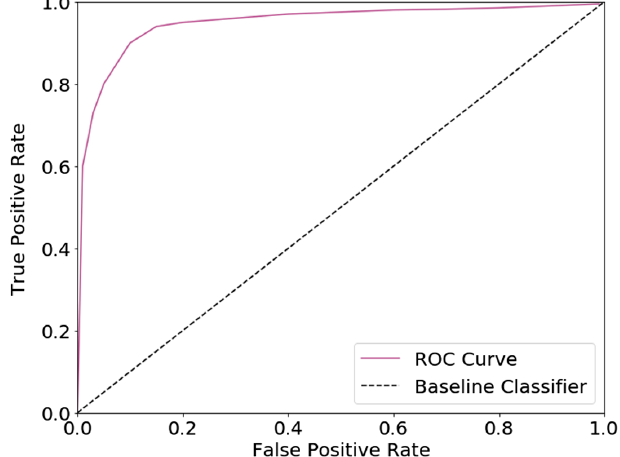
FIG. 4. An example ROC curve. This curve represents a model that is performing well, as it is to the upper left-hand corner. The plot suggests that there is a threshold of probability to classify something as the positive category that will result in a high true positive rate, and a corresponding low false positive rate. For comparison, the dashed line represents the expected ROC curve for a random